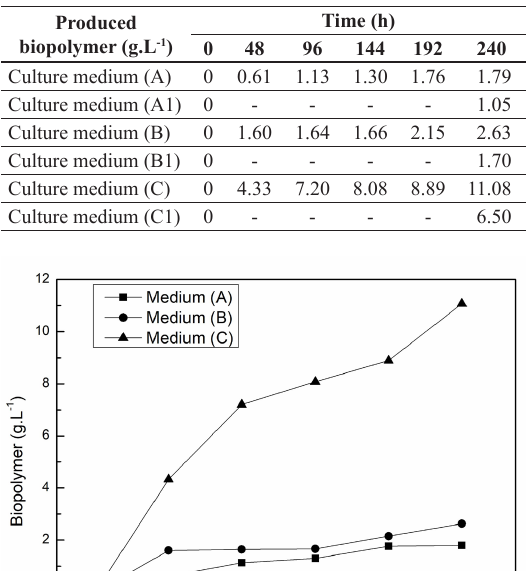
Table 1. Monitoring the production of biopolymer in the culture media evaluated at various times.